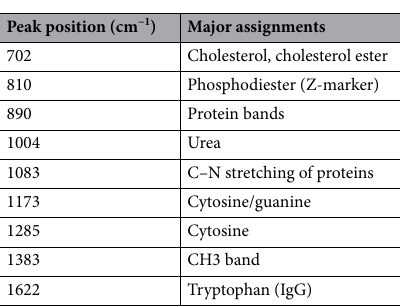
Table 2. Summarize previous reported SERS peak positions and vibration mode assignments 1 .